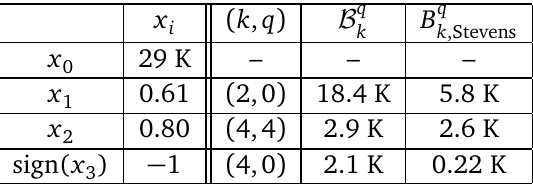
Table 1: Stevens parameters for CeAgSb mental data from Ref. [ 43 ] of observables { µ α α = { x ≡ [ 100 ] , z ≡ [ 001 ] } . The coefficients x